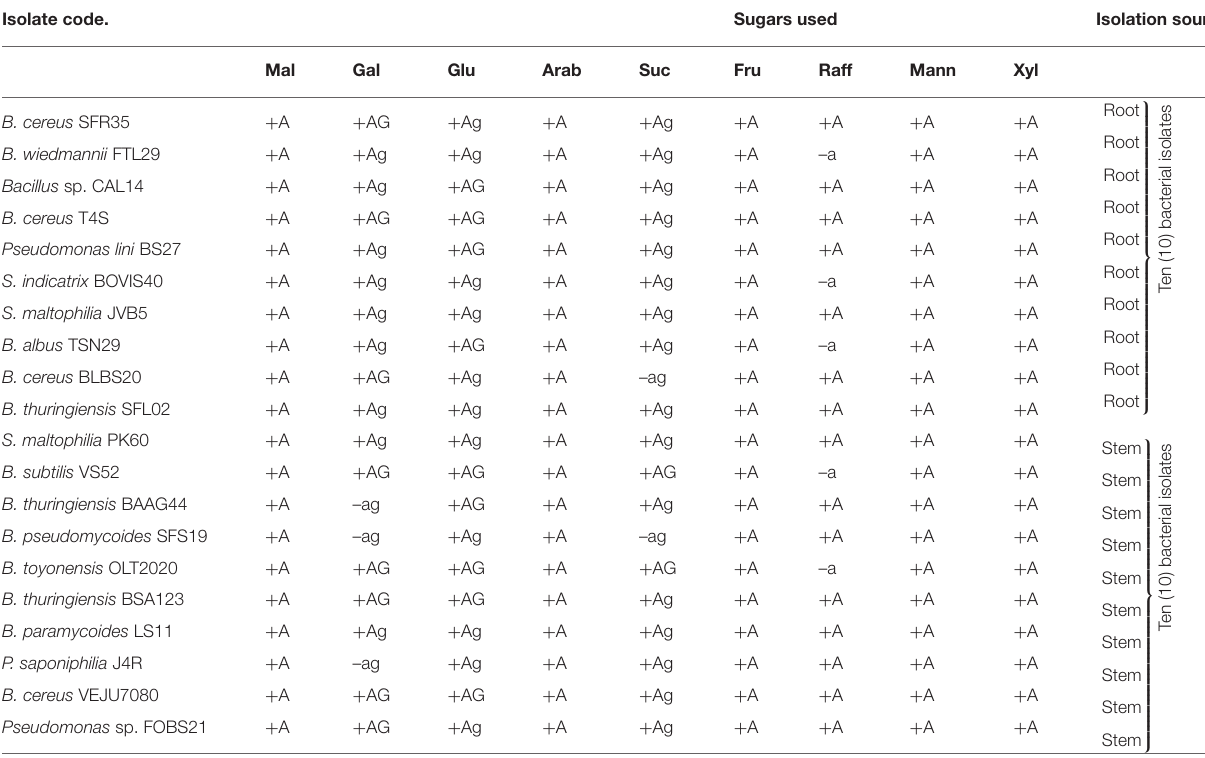
TABLE 1B | Sugar utilization by endophytic bacteria from sunflowers. Isolate